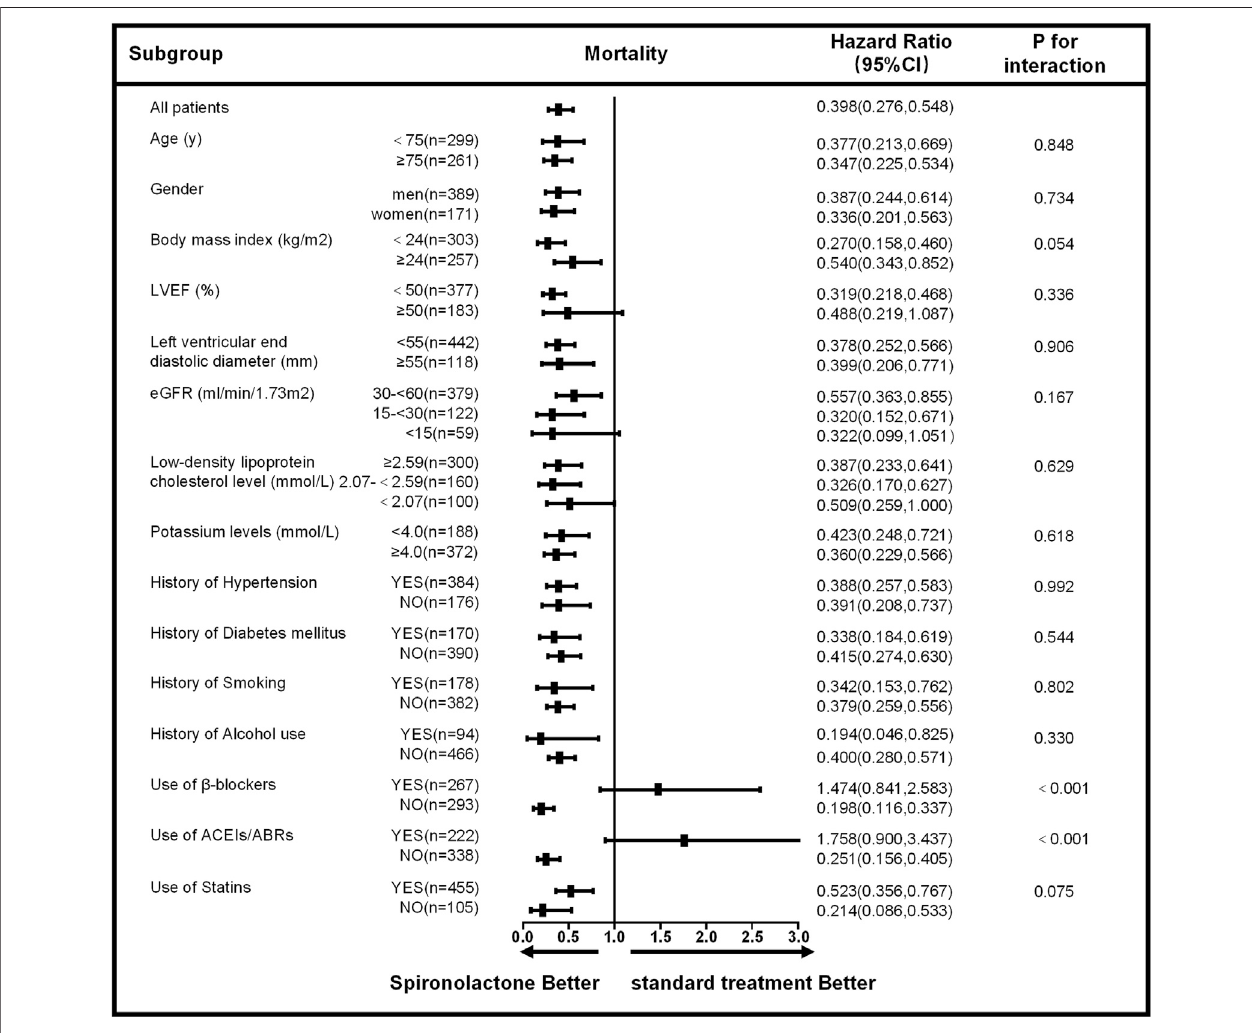
FIGURE3| Subgroupanalysisofall-cause mortalitybased onthelong-termfollow-up.LVEF, left ventricular ejectionfraction;eGFR, estimated glomerular fi ltration rate; ACEIs, angiotensin-converting enzyme inhibitors; ARBs, angiotensin receptor blockers; CI, con fi dence interval.